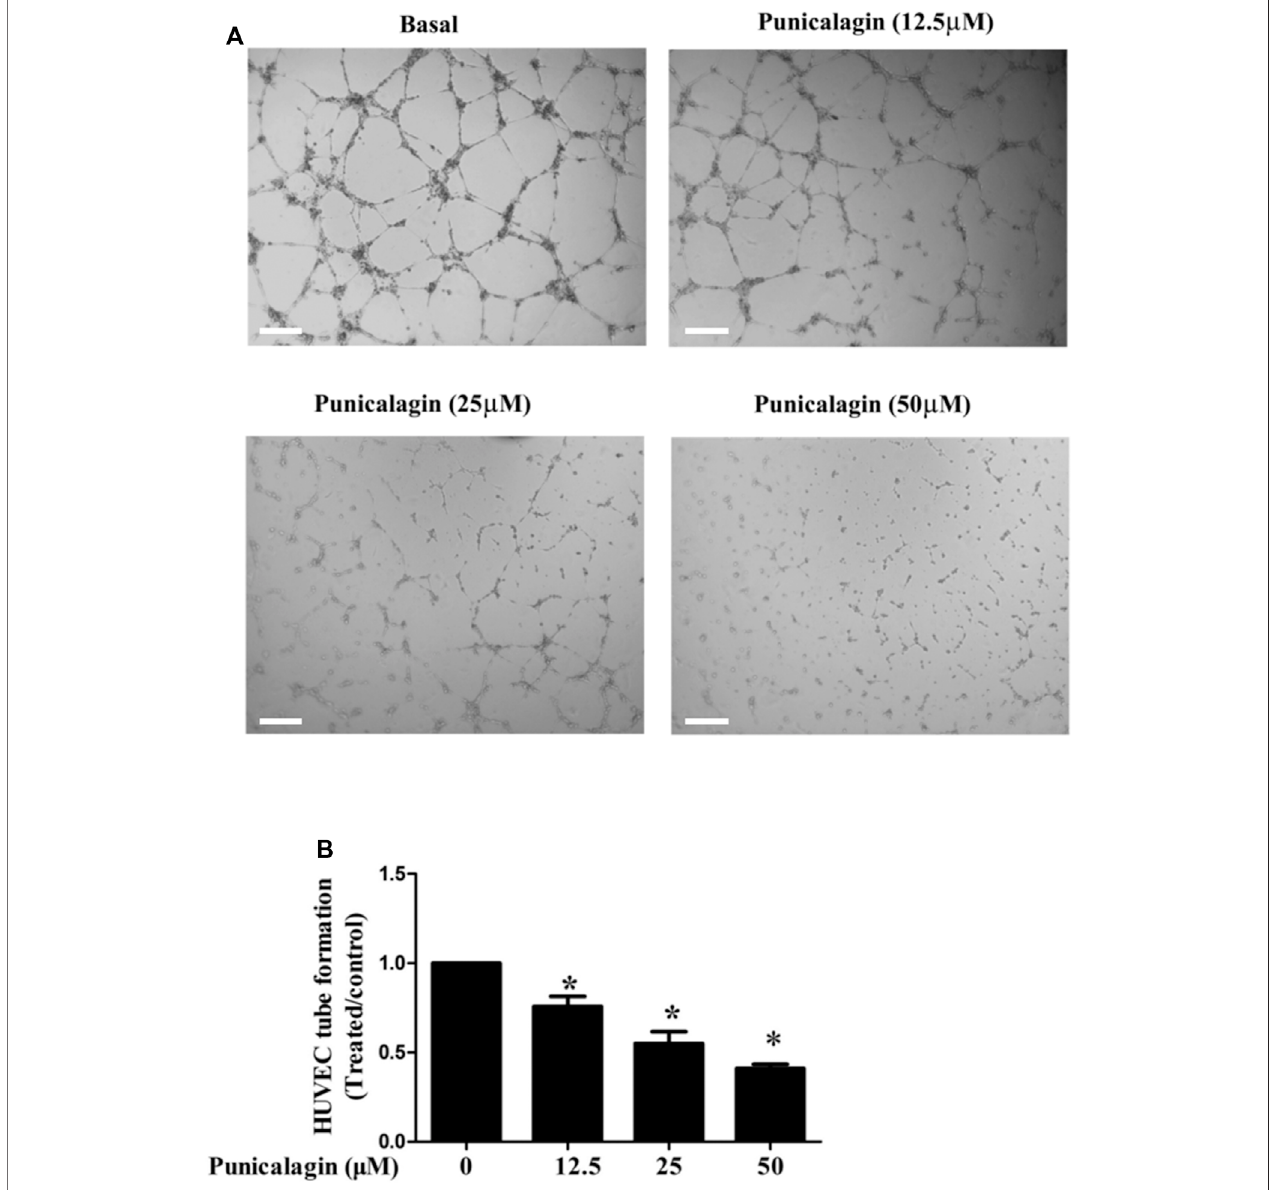
FIGURE 6 | Effects of punicalagin on HUVECs tube formation. (A) The effect of punicalagin on the formation of tubular structure in endothelial cells. HUVECs were seeded on Matrigel layer, after they were resuspended with punicalagin containing 12.5, 25, and 50 μ M. The formation of vascular-like structures in different concentration groups after 8 h was evaluated. (B) The histogram represents the dose response for punicalagin in tube formation of HUVECs. * p < 0.05, punicalagin treatment vs. control group.